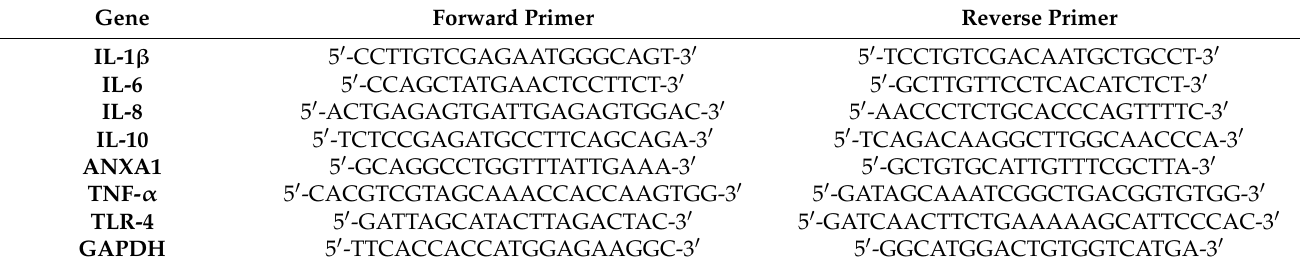
Table 1. Sequences of primers